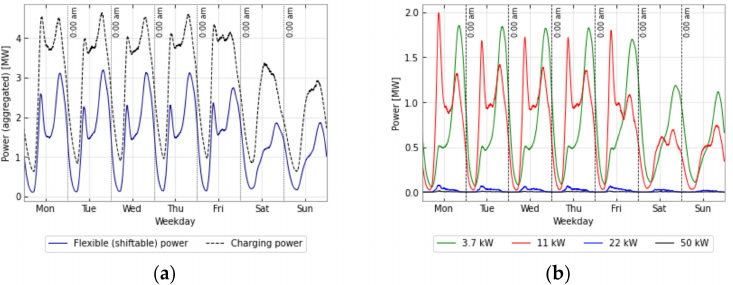
Figure 4. ( a ) Average power profile and flexible (shiftable) power; ( b ) Flexible (shiftable) power per charging power used.